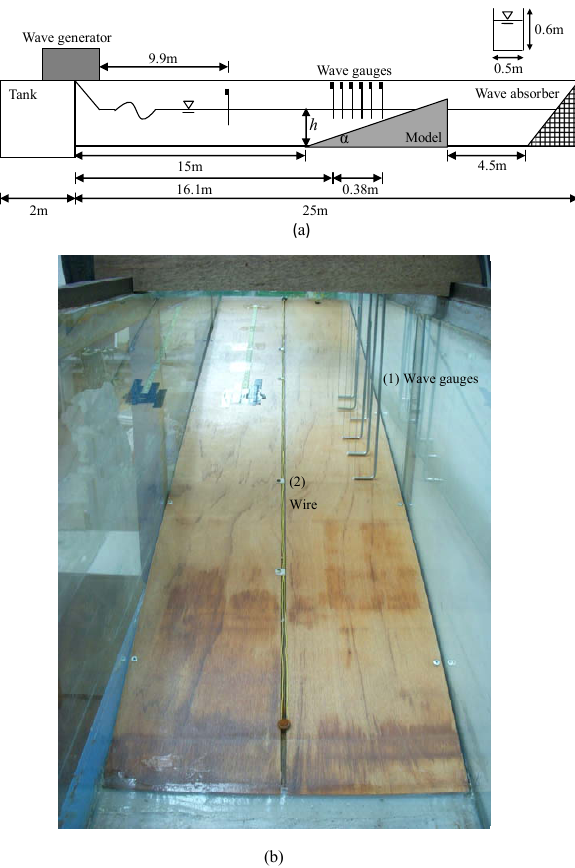
Figure 1. Experimental setup: (a) wave flume and (b) wave gauges and a wire for measuring 4 Fig. 1. Experimental setup: (a) wave flume and (b) wave gauges wave height and run-up. 5 and a wire for measuring wave height and